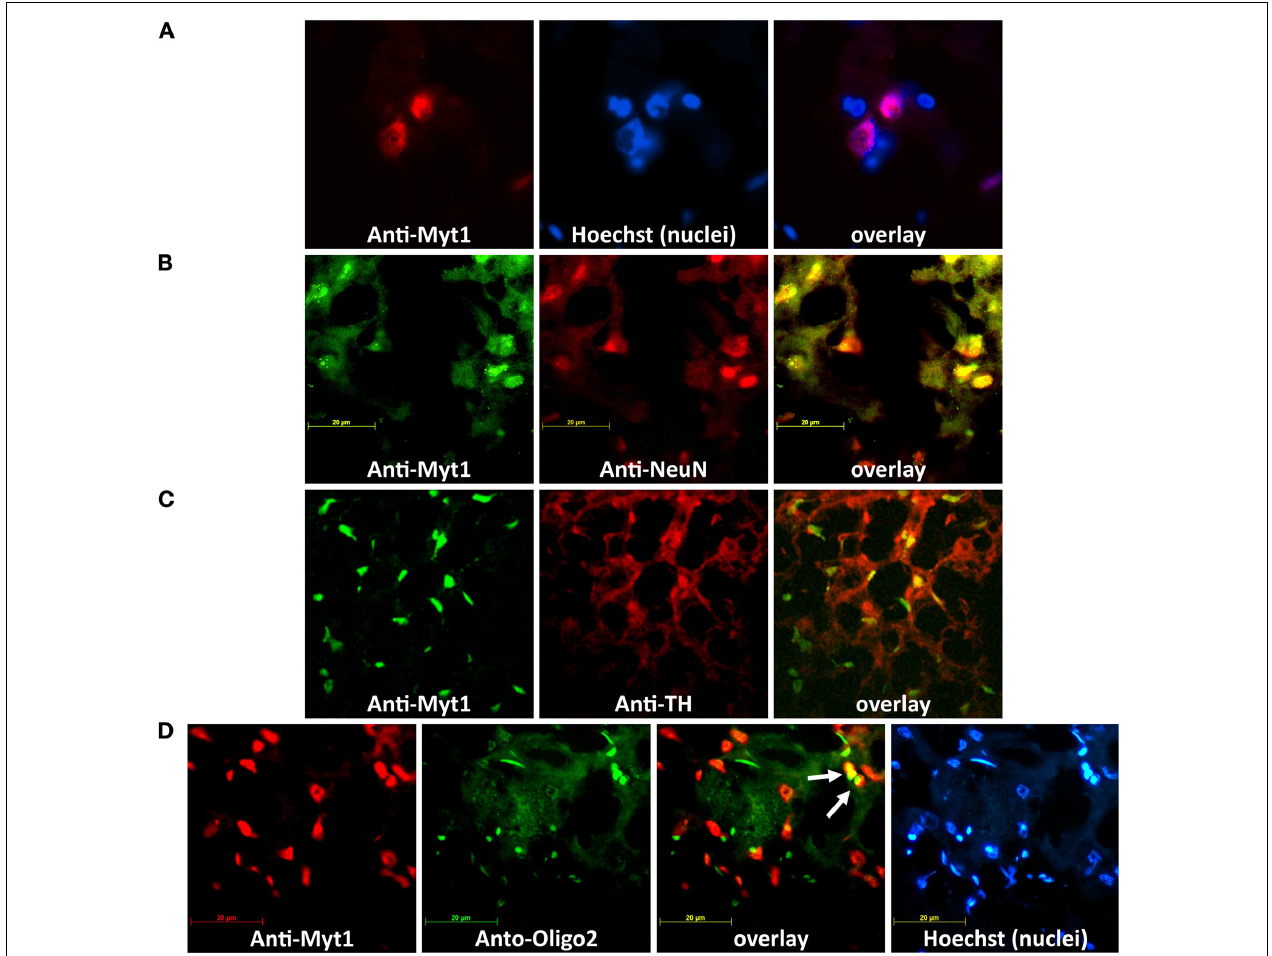
FIGURE 4 | Lentivirus-mediated expression of NZF-2b/7ZFMyt1 recruits and co-localizes with HDAC2 in neuronal nuclei in the NAc. Animals were sacrifi ced at the end of cocaine self-administration behavioral tests, either in the presence or absence of doxycycline. Brains were dissected out and processed for immuno-histochemistry (see Materials and Methods). (Scale bar: 20 µm). (A) Double immunostaining with anti-Myt1 antibody (red) and Hoechst nuclei staining (blue) (100 × magnifi cation); merged image shows that the NZF-2b/7ZFMyt1 expression is localized in most if not all cell nuclei in the NAc. (B) Double immunostaining with anti-Myt1 antibodies for detecting NZF-2b/7ZFMyt1 protein (green) and anti-NeuN (a neuronal nuclei marker; red) (100 × magnifi cation); merged image shows that NZF-2b/7ZFMyt1